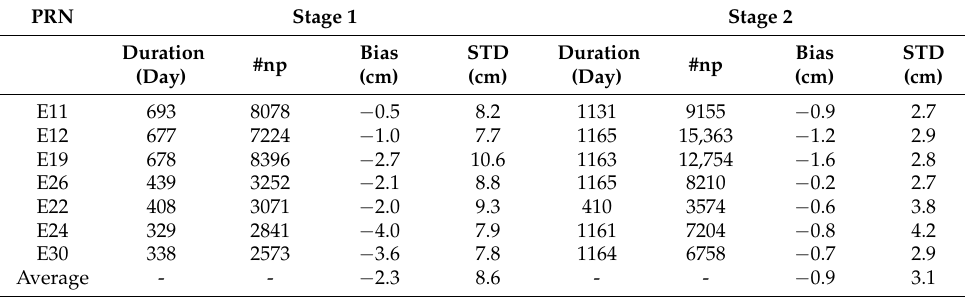
Figure 7. SLR residuals for GBM orbits. Table 6. Statistical information for SLR residuals calculated from GBM